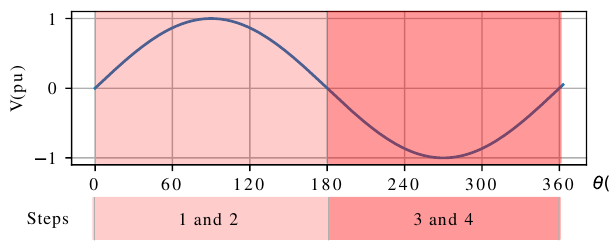
Figure 4. Steps of operation in each half cycle of R load voltage.